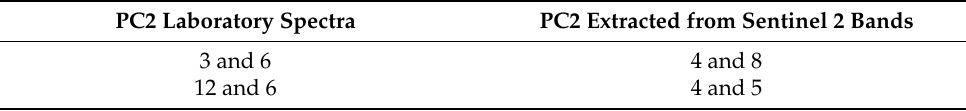
Table 3. PCA on two bands developed through spectral analysis of spectra collected in the laboratory and extracted from Sentinel 2